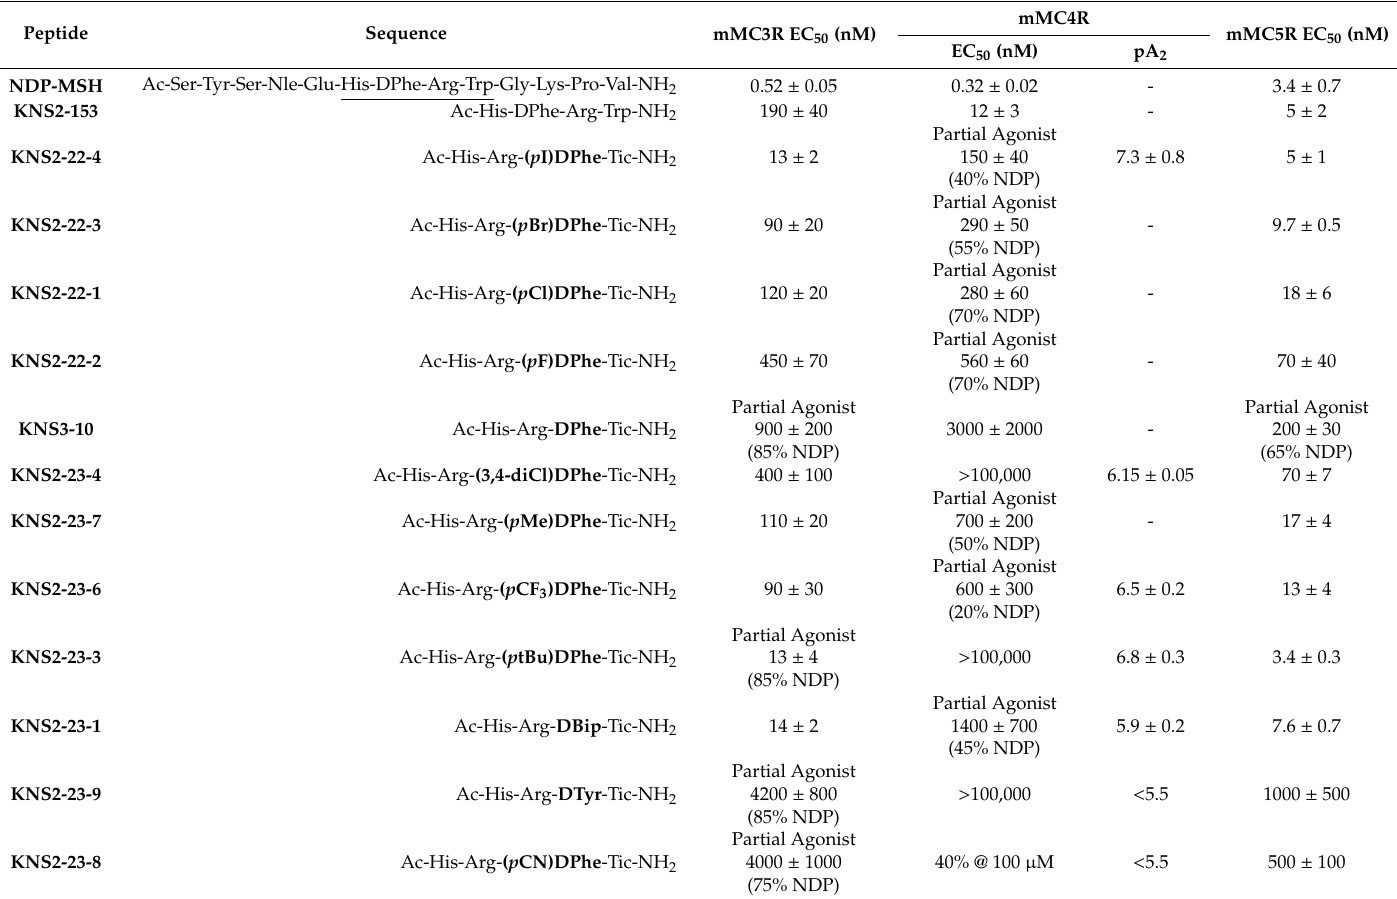
Table 3. Tetrapeptide pharmacology at the mouse melanocortin-3, -4, and -5 receptors using the β -Galactosidase cAMP assay a